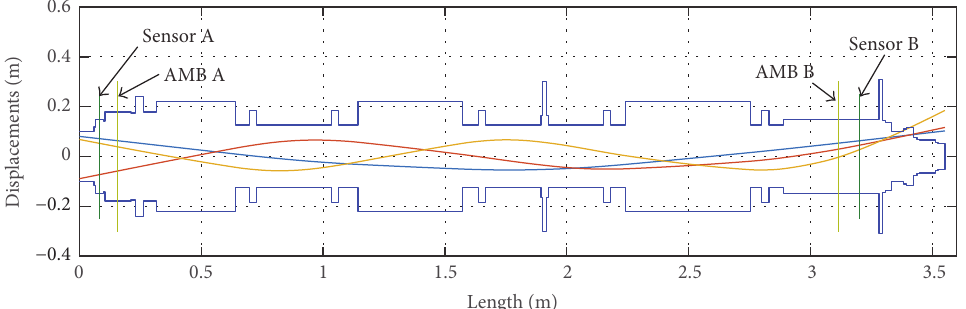
Figure 4: The undamped free-free mode shape of the